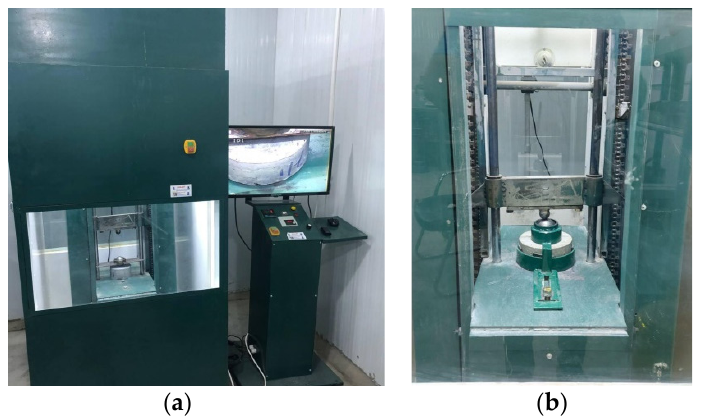
Figure 6. Repeated impact testing. ( a ) Testing machine; ( b ) Specimen testing.